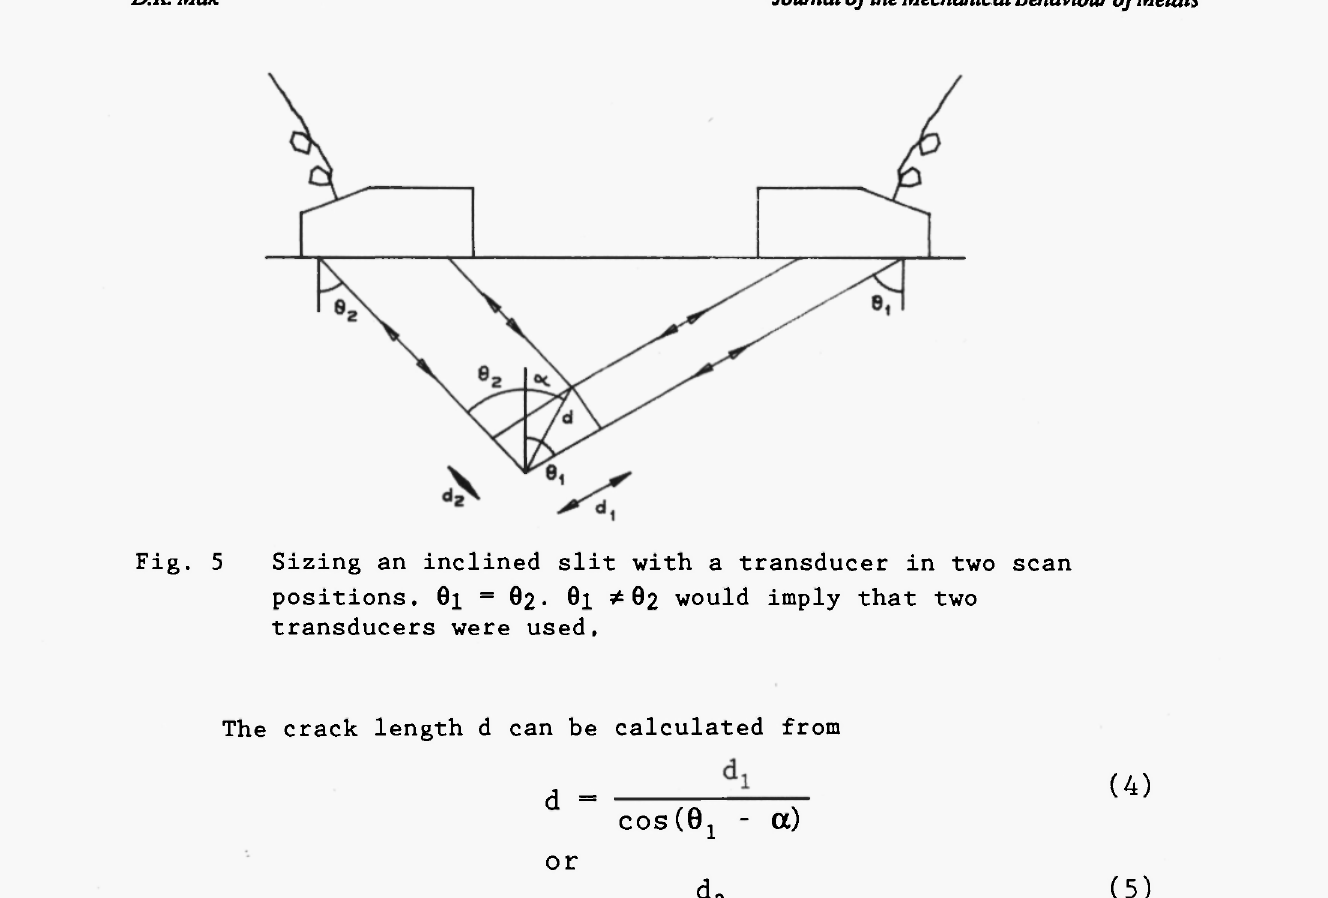
Fig. 5 Sizing an inclined slit with a transducer in two scan positions, θι = 0 2· θι * 02 would imply that two transducers were used.